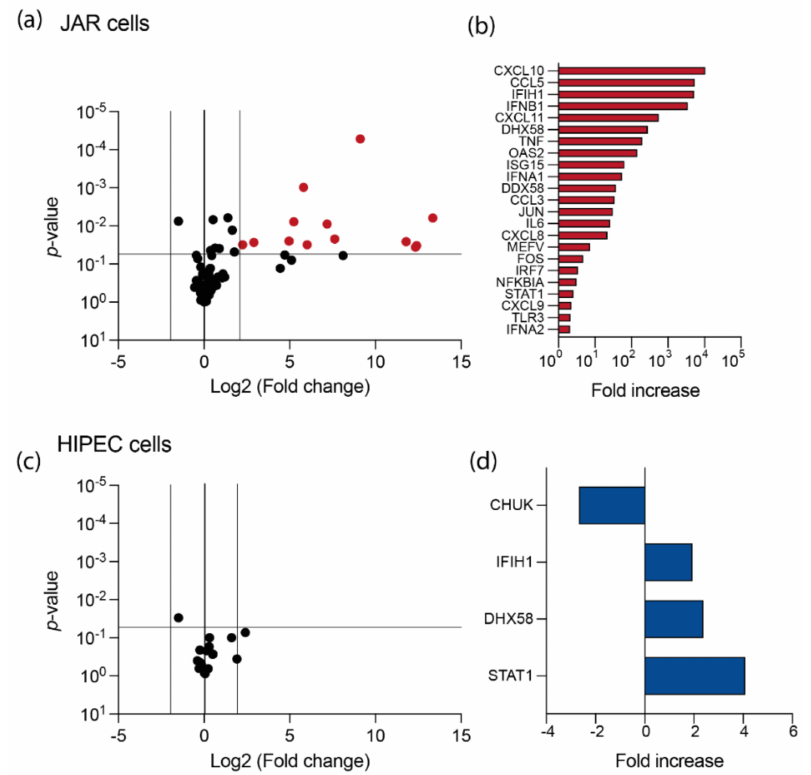
Figure 3. Characterization of innate immune responses of HIPEC and JAR cells upon USUV infection. ( a ) And ( c ) volcano plot representing differences in normalized mean mRNA expression in JAR cells ( a ) or HIPECs ( c ) 16 h upon USUV infection compared to non-infected cells, from three independent experiments. mRNAs exhibiting significant differences upon infection are represented by colored circles (Student’s t -test p -value ≤ 0.05 and log2 ratio ≥ 2 or ≤ − 2). ( b – d ) Detail of the under- and over-expressed mRNAs upon USUV infection in JAR cells ( b ) or HIPECs ( d